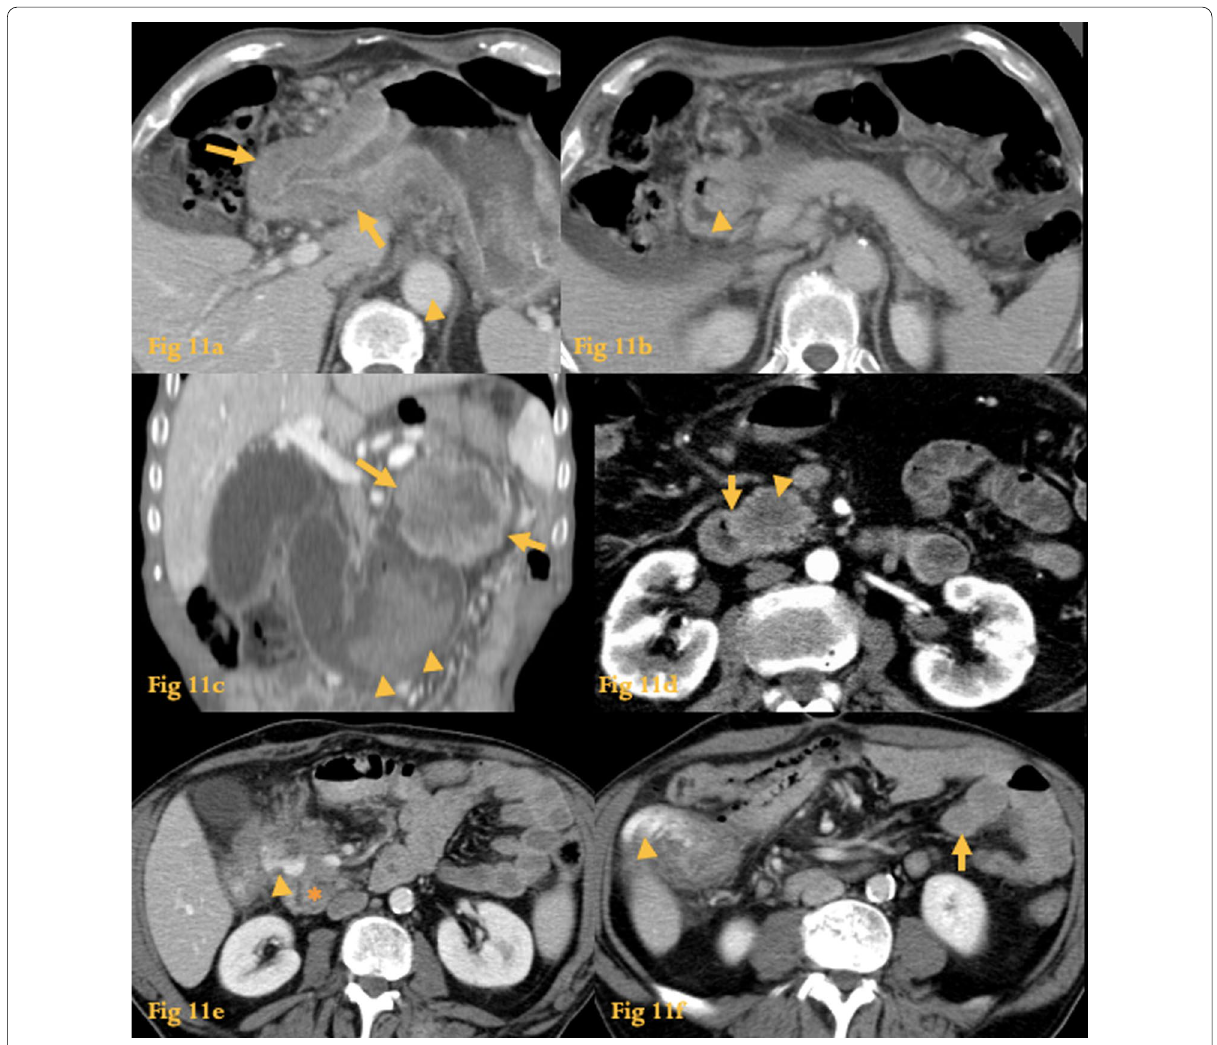
Fig. 11 Extension from adjacent tumor. Abdominal CT ( a , b ) shows circumferential wall thickening of the gastric antrum (arrows) extending through the pylorus into D1 and D2, where a polypoid‑like lesion (arrowhead) narrows the lumen. CT of another patient ( c ) shows evidence of gastric adenocarcinoma (arrows) with duodenal invasion and hemorrhage (arrowheads) inside the duodenal lumen. Abdominal CT of other patient ( d ) shows a hypodense soft‑tissue density mass (arrowhead) which was a pancreatic adenocarcinoma with invasion of the medial wall of D2 (arrow). Abdominal CT of a patient with a neoplasm of the hepatic flexure of the colon ( e , f ). An undefined mass apparently involves the duodenum (asterisk) and the colon. A small amount of positive oral contrast agent (arrowhead) is present within the mass. An image obtained caudally ( f ) shows oral contrast agent in the colon (arrowhead) without evidence of contrast in the jejunum (arrow), a feature related to a colo‑duodenal